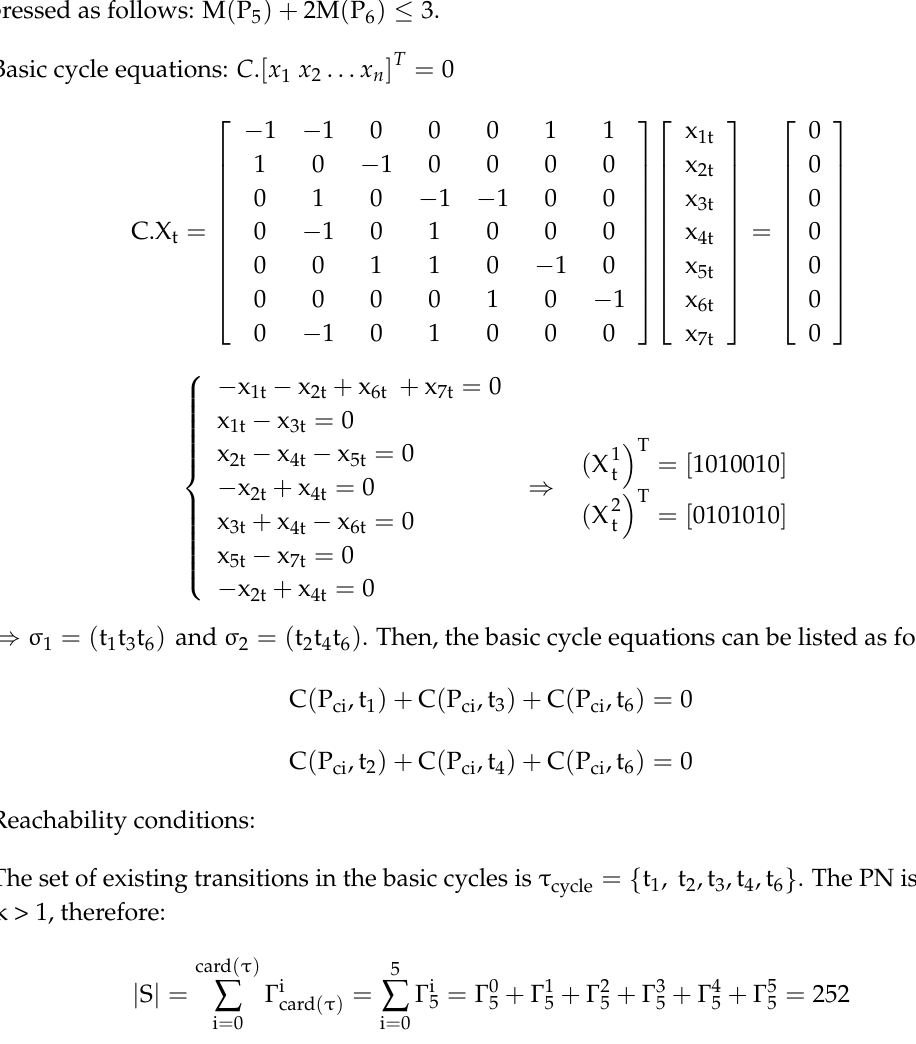
Table 9. Usable sequences of Example 3.